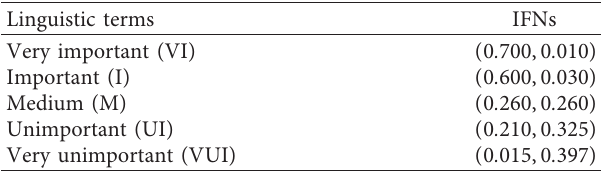
Table 23: Linguistic terms for rating the importance of alternatives. Linguistic terms IFNs Extremely good (EG)/extremely high (EH) ( 0 . 995 , 0 . 000 ) Very very good (VVG)/very very high (VVH)